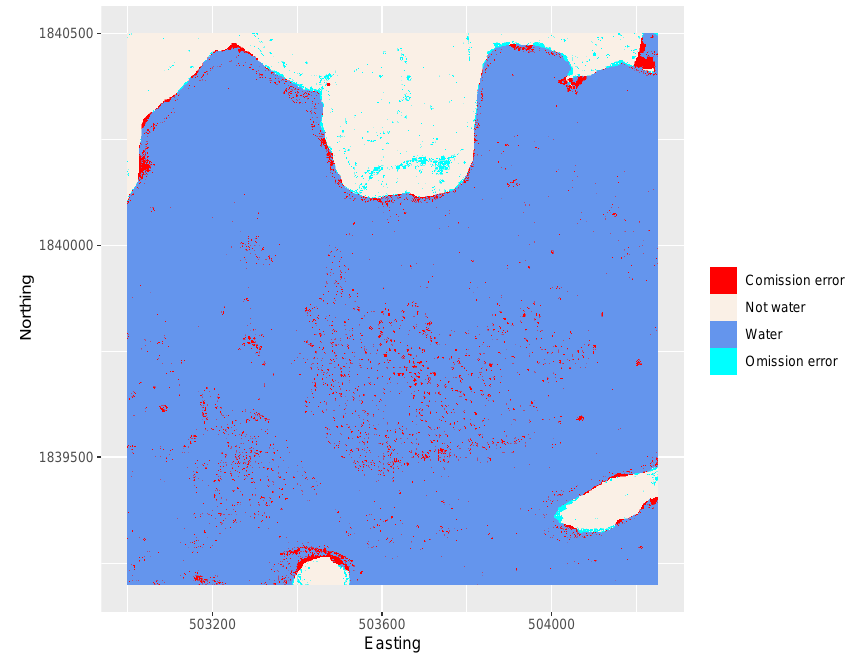
Figure 3. Comparison of water delineation based on field stage observation and DTM vs. pixels classified as water and non-water based on high resolution drone imagery, 12 October